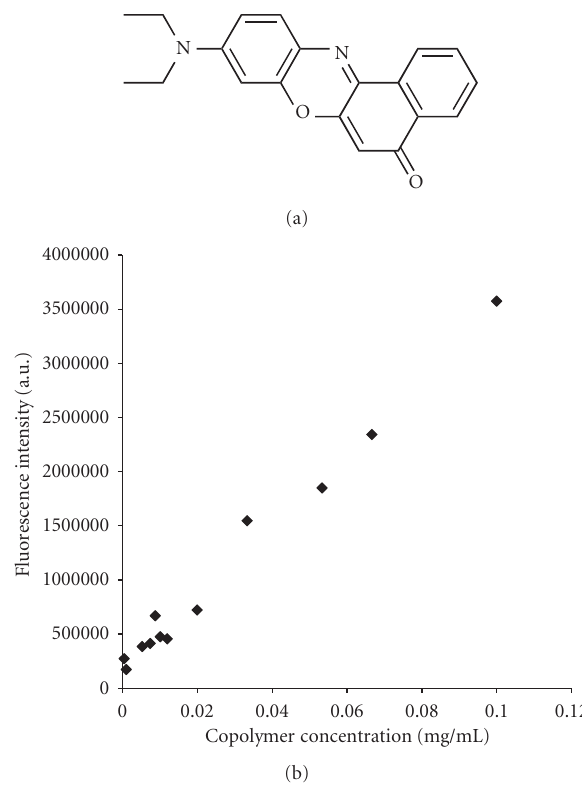
Figure 5: (a) Chemical structure of Nile Red; (b) fluorescence intensity of Nile Red as a function of copolymer concentration, illustrating a relatively linear relationship between concentration and fluorescence intensity over the concentration range from 0.5 to 100 μ g/mL.